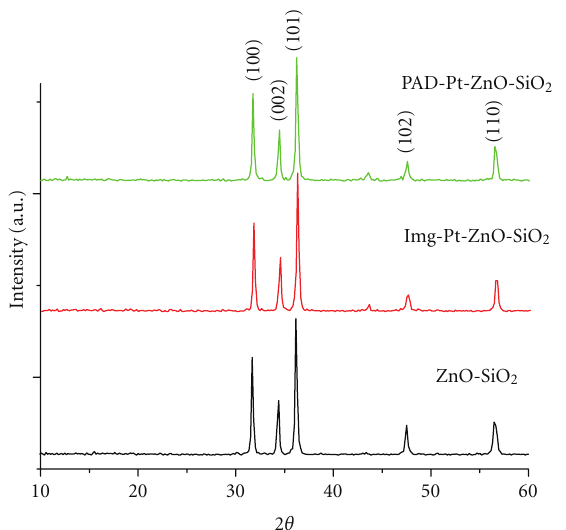
Figure 1: XRD patterns of the (ZnO-SiO 2 , Img: Pt-ZnO-SiO 2 and PAD: Pt-ZnO-SiO 2 ).